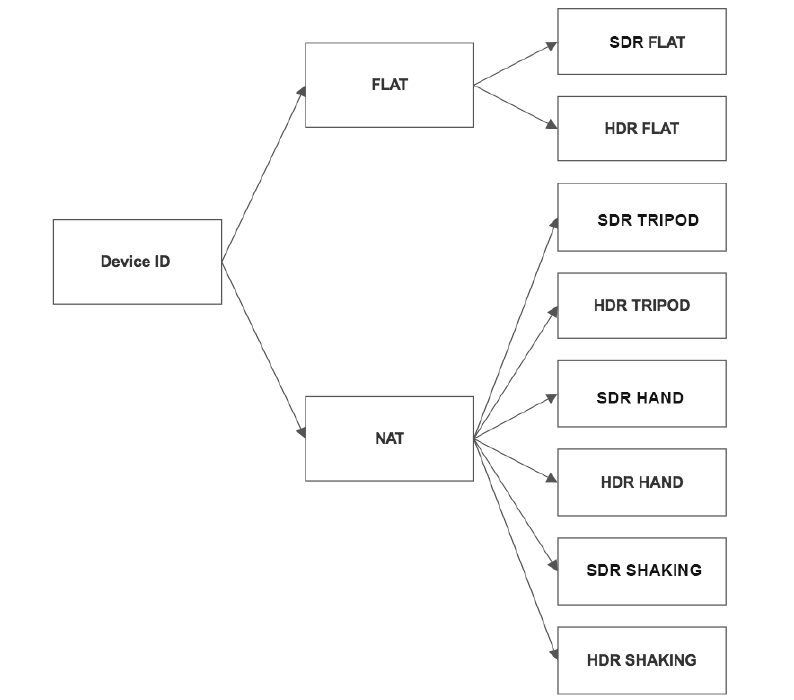
Figure 2. The dataset structure.